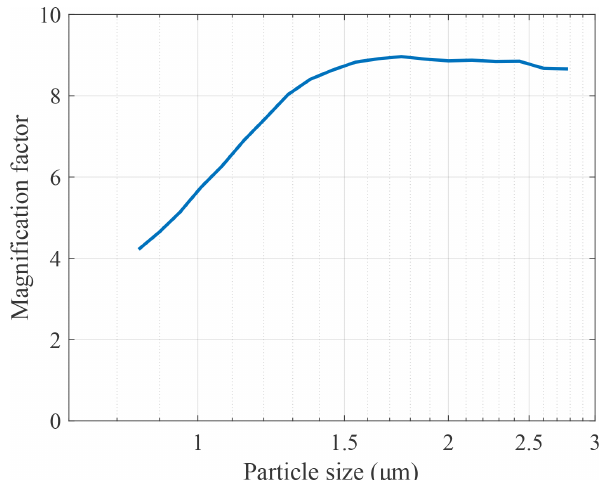
Figure A1. Measured magnification factor for the virtual impactor (VI)-type concentrator used with SPIN during the HyICE-2018 campaign. Flow rates of 20 and 2Lmin − 1 were used for the sheath flow and sample flow, respectively.